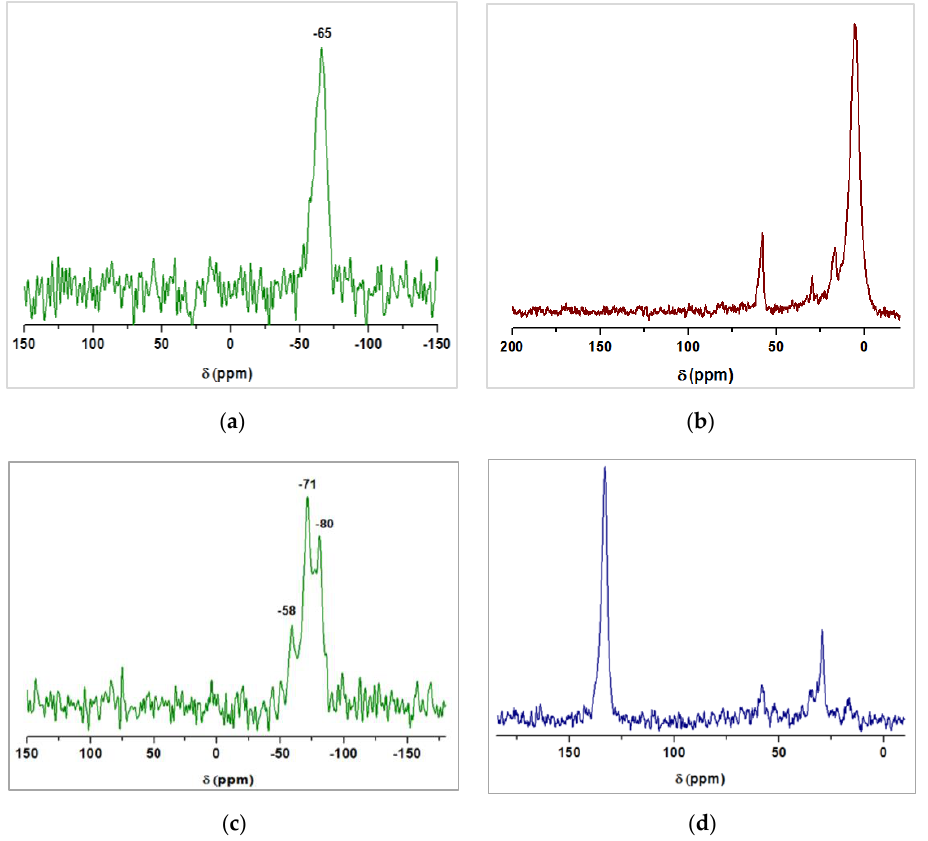
Figure 10. 29 Si and 13 C CP-MAS of M-Ethylene PMO-NPs ( a , b ) and M-Phenylene PMO NPs ( c , d ).